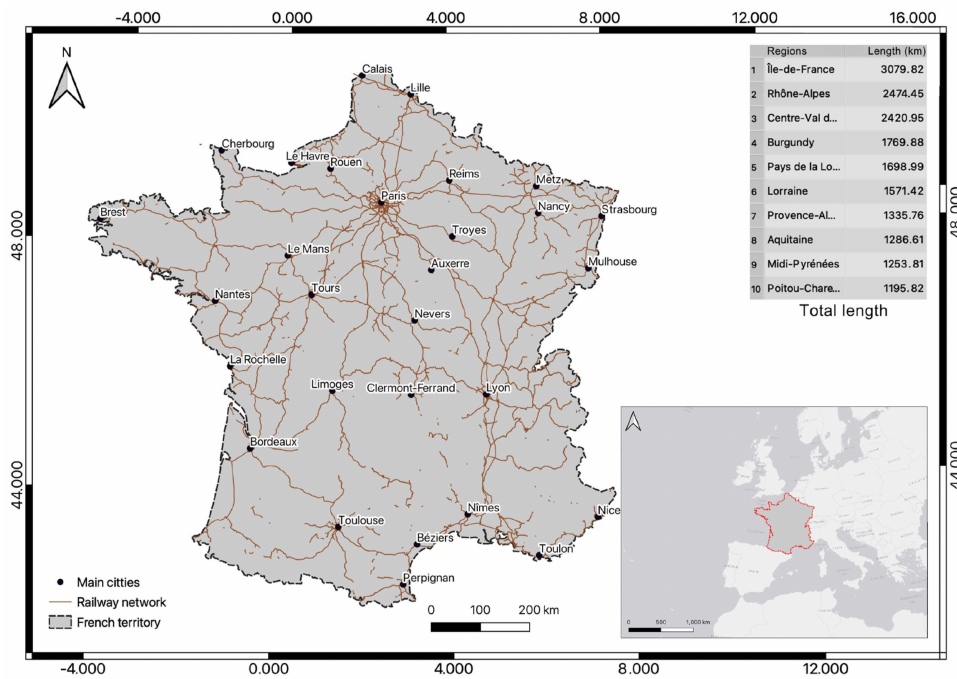
Figure 2. Railway system in